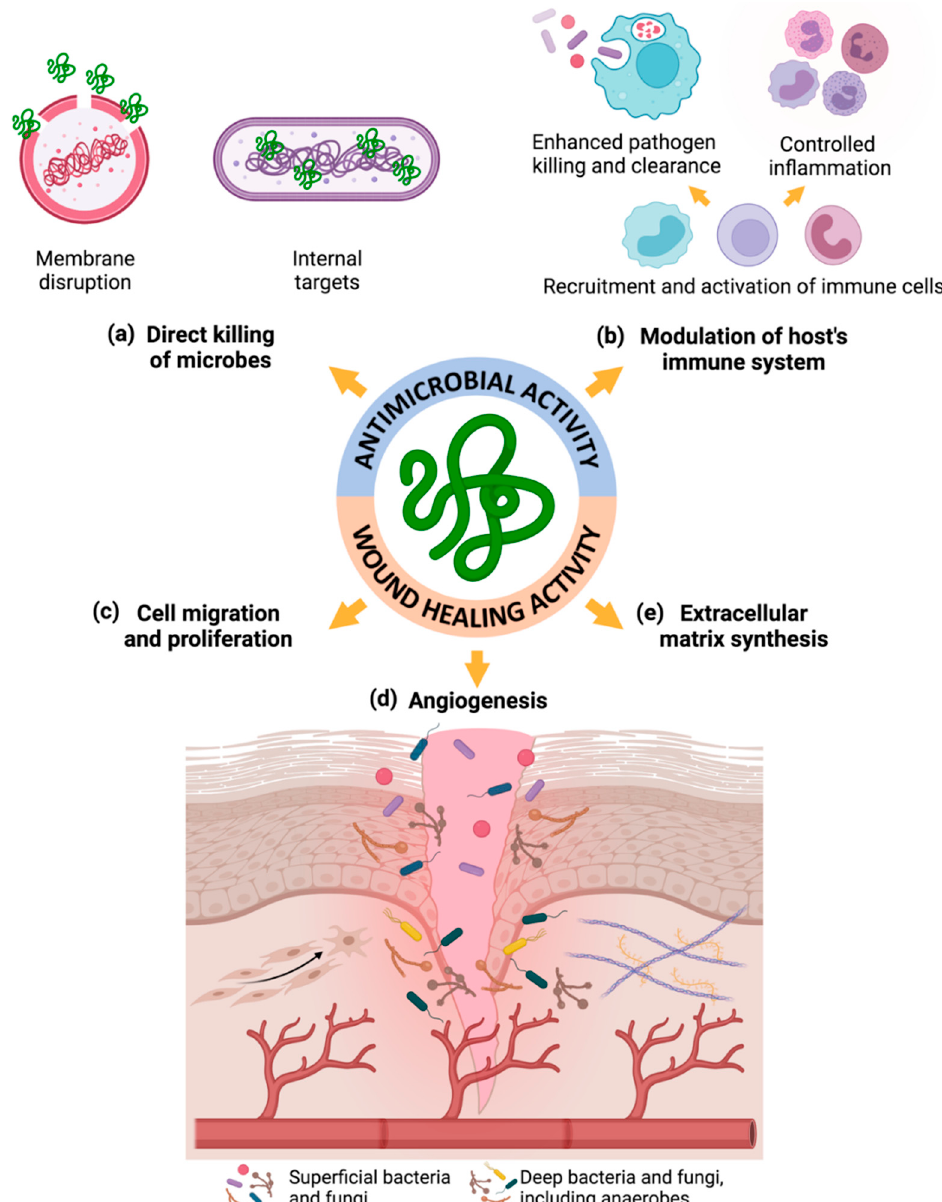
Figure 1. Mechanisms of action of AMPs supporting their therapeutic application for treating infected non-healing wounds—unraveled antimicrobial and wound-healing properties: ( a ) direct killing of microbes; ( b ) modulation of the host’s immune system; ( c ) promotion of cell migration and proliferation; ( d ) induction of angiogenesis; and ( e ) enhancement of extracellular matrix synthesis. Figure created in BioRender.com (accessed on 9 November 2021).